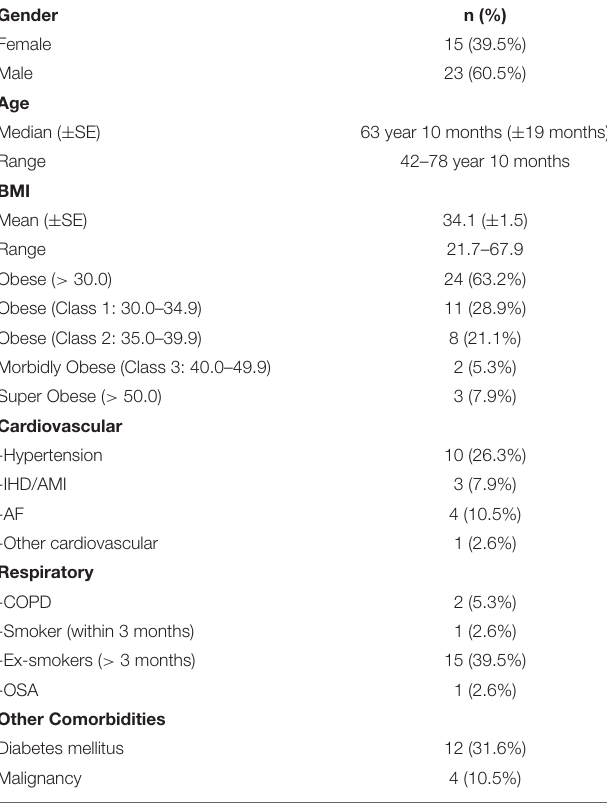
TABLE 1 | Demographic of patients undergoing preoperative PPP prior to repair of complex ventral